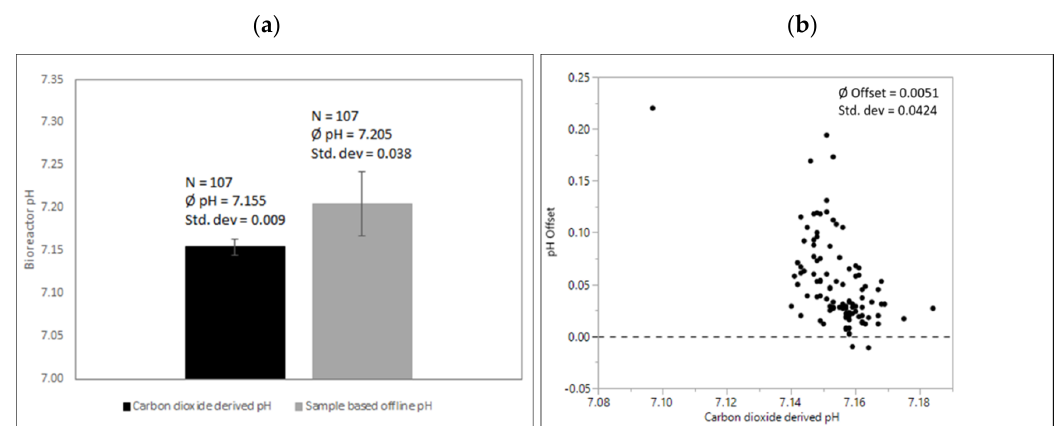
Figure 7. ( a ) Comparison of carbon dioxide-derived and sample-based pH before inoculation after media fill. Processes were executed from various operators over a period of several months with the same culture media recipe and the same conditions at the calibration time point as described. ( b ) pH offsets of sample-based offline values compared to quadratic fit for correlation exhaust carbon dioxide concentration and corresponding pH. Due to its small volume and automated handling, exposure to carbon dioxide free environmental conditions is considered high.